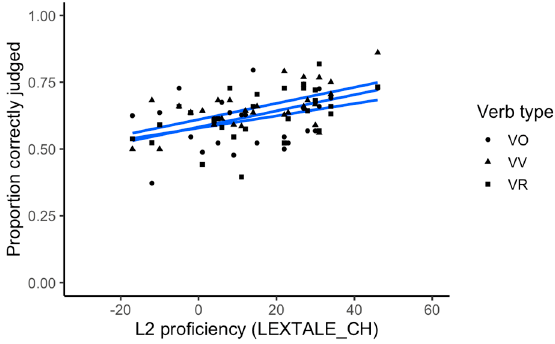
Figure 4. Grammaticality judgement accuracy along L2 proficiency.